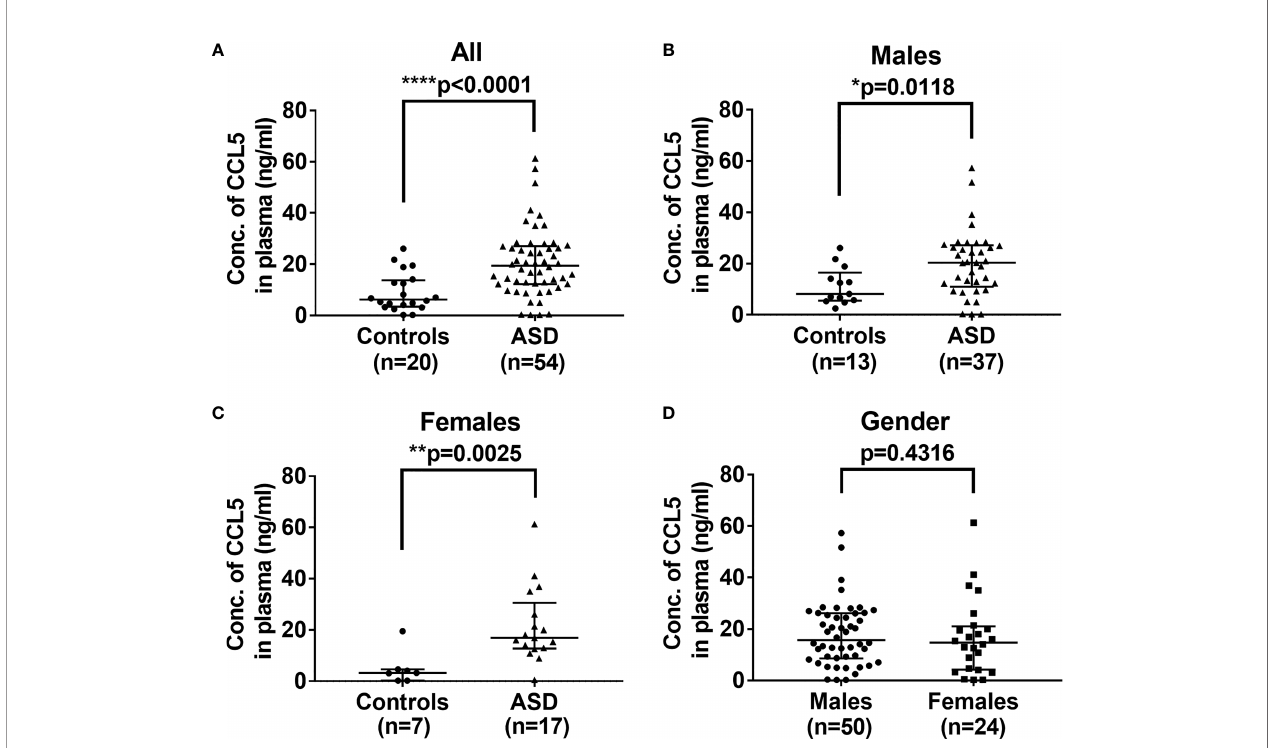
FIGURE 1 | Comparison of levels of plasma CCL5 between ASD and the controls. (A) Plasma levels of CCL5 were signi fi cantly higher in ASD children, as compared with age- and sex-matched control children. (B) Plasma levels of CCL5 were signi fi cantly higher in ASD boys compared to age- and sex-matched boys in the control group. (C) Plasma levels of CCL5 were signi fi cantly higher in ASD girls compared to age- and sex-matched girls in the control group. (D) No difference in plasma levels of CCL5 between boys and girls enrolled in the study. Statistical analyses were performed using the non-parametric Mann-Whitney U test. Statistical signi fi cance is denoted by * p < 0.05, ** p < 0.01, and **** p <